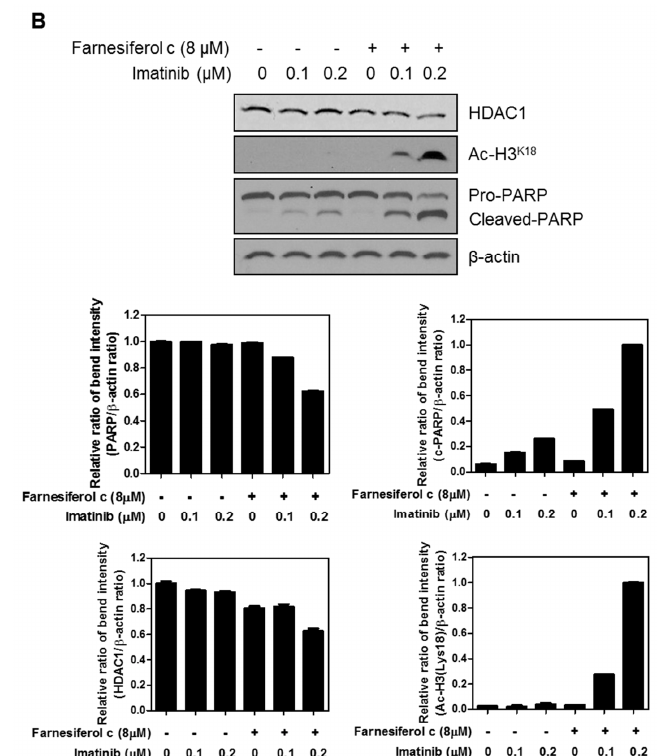
Figure 6. Combinatorial e ff ect of FC and Imatinib in K562 cells ( A ) K562 cells were distributed into 96 well microplates and were exposed to Imatinib (0, 0.1, 0.2 µ M) and / or FC (8 µ M) for 24 h. Cell viability was evaluated by an MTT assay. *, p value < 0.05 between Imatinib alone and FC and Imatinib. ( B ) E ff ect of FC on HDAC1, acetylation H3 (K18), and PARP in a concentration dependent fashion in K562 cells. Cell extracts were prepared and subjected to Western blotting was conducted with cell extracts by using HDAC1 and 2 antibodies. β -actin was used as an internal